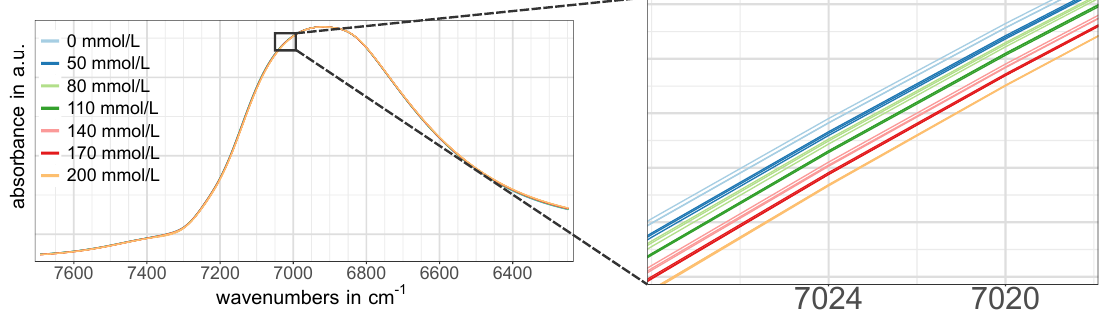
Figure 4. Illustration of the glucose concentration dependent pattern in the water band located at around 6900 cm − 1 (region W1). NIR spectra of the calibration set recorded with the 0.1 mm cell are shown here